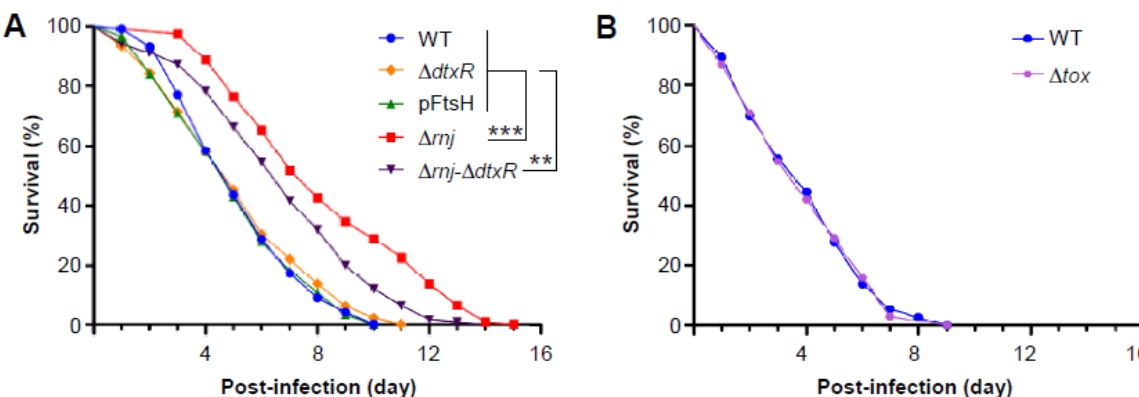
Figure 5. Virulence attenuation of the ∆ rnj mutant in a C. elegans model of infection. ( A ) L4-stage nematodes of strain N2 were fed on corynebacteria of strains NCTC 13129 (WT, blue circles), NCTC 13129 overexpressing FtsH (green triangles), ∆ rnj mutant (red squares), ∆ dtxR mutant (orange diamonds), or ∆ rnj - ∆ dtxR mutant (black triangles). Dead nematodes were recorded and removed every 24 h. ( B ) A similar experiment as described in ( A ) was carried out with the WT and ∆ tox mutant (purple hexagons) strains. The results are presented as survival percentage, and statistical analysis was performed using GraphPad Prism 5.0. Asterisks ** and *** indicate p values of <0.01 and <0.001, respectively. Table 3. Siderophore production of C. diphtheriae strains in high- or low-iron media.